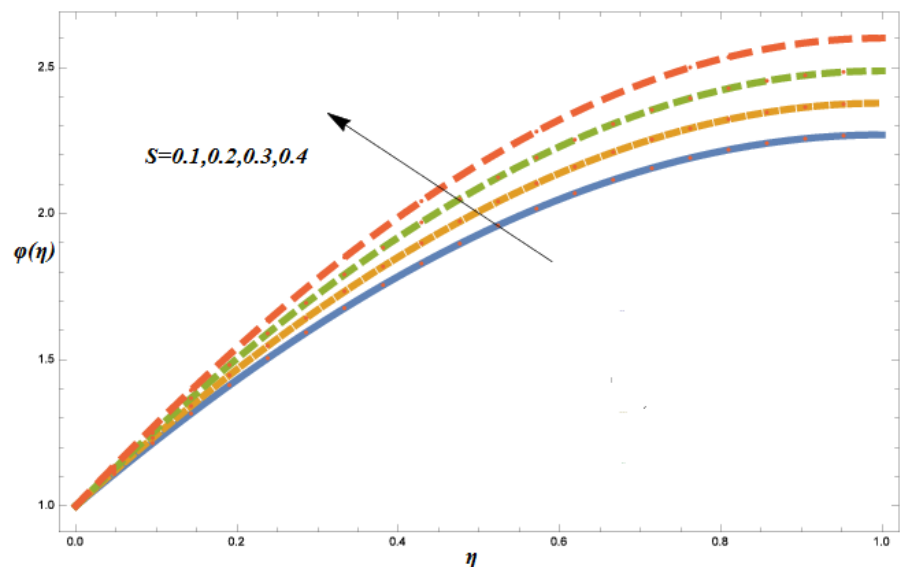
Figure 9. Variations in concentration field ϕ ( η ) occur for different numbers of S , when (cid:125) = − 0.25, P r = 10, B r = 0.7, N r = 0.7, D u = 0.7, S c = 0.7, ε = 0.7, S r = 0.7, λ = 0.7, Λ = 0.7, β = 1.